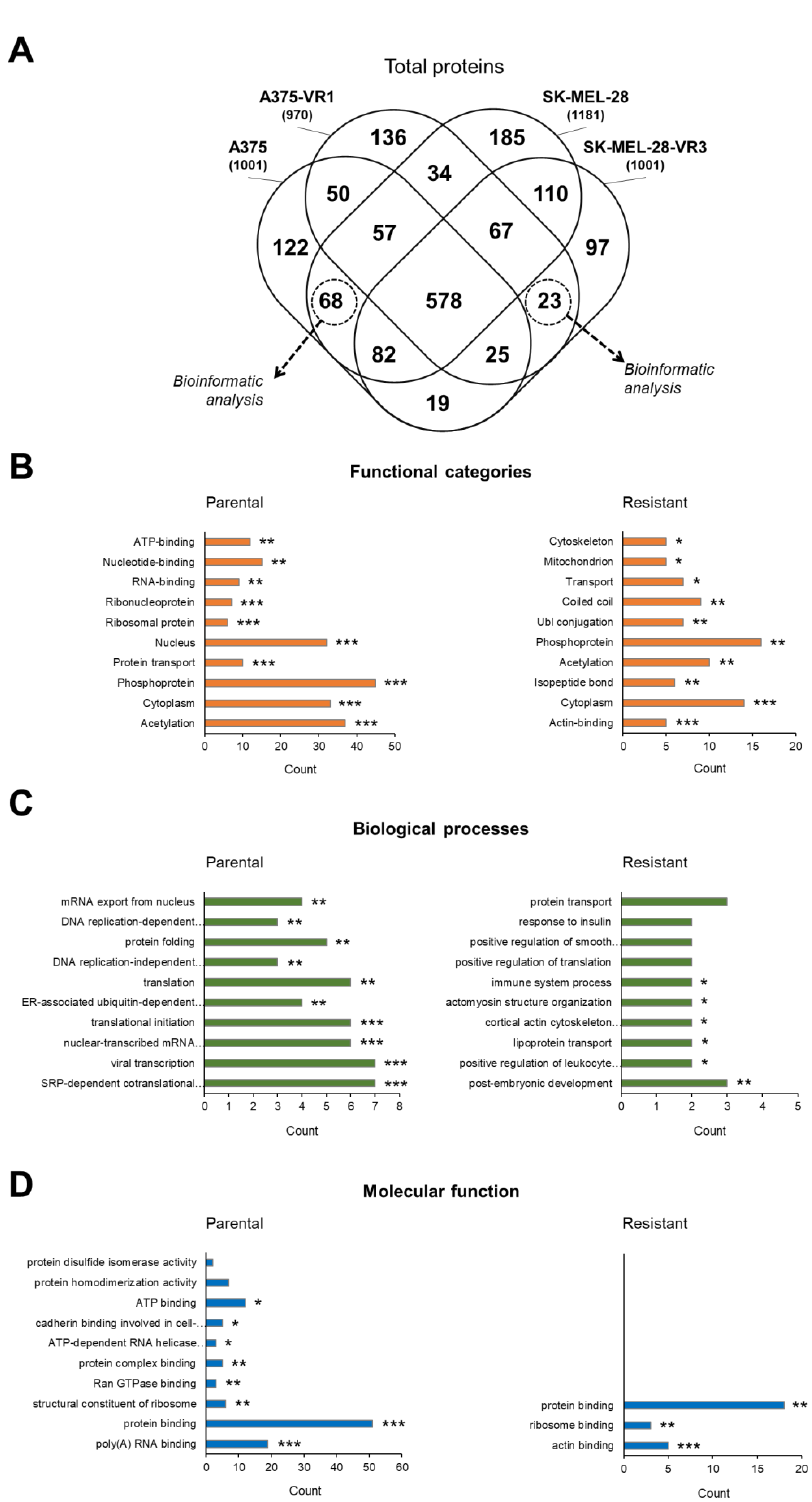
Figure 2. Proteomic analysis of total differentially expressed proteins. ( A ) Venn diagram representing the overlap in the identified proteins in each cell line. A total of 68 and 23 specific common proteins were identified in parental and resistant cells, respectively. Enriched gene ontology (GO) analysis of the identified common specific proteins using DAVID classification based on ( B ) functional categories, ( C ) biological processes, and ( D ) molecular function (count indicates the number of proteins involved in the term). Top 10 terms of DAVID functional annotation chart were shown and ordered according to the statistical significance: * p -value < 0.05; ** p -value < 0.01; *** p -value <